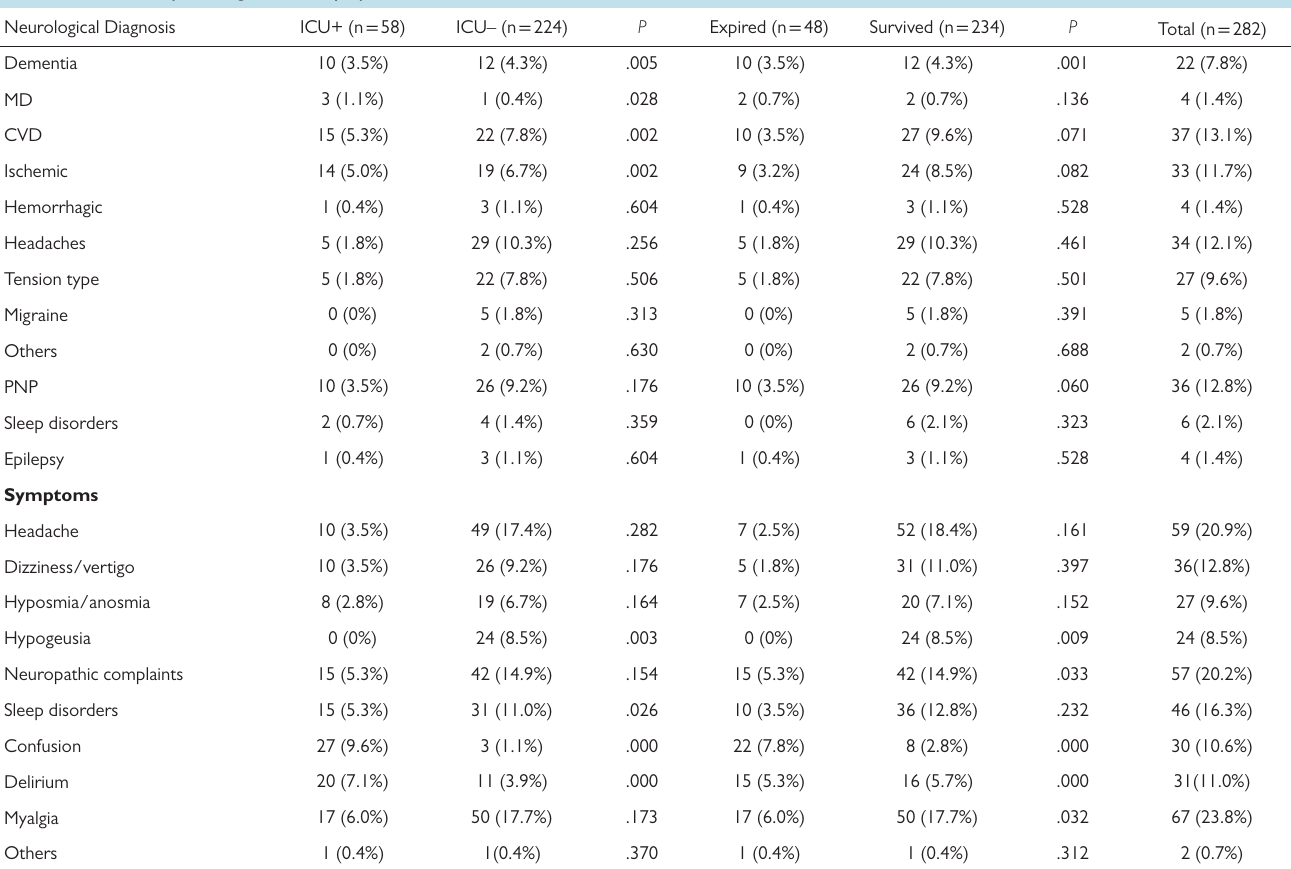
Table 2. Relationship of Diagnosis and Symptoms with Clinical Parameters Neurological Diagnosis ICU+ (n = 58) ICU– (n = 224) P Expired (n = 48) Survived (n = 234) P Total (n = 282) Dementia 10 (3.5%) 12 (4.3%)